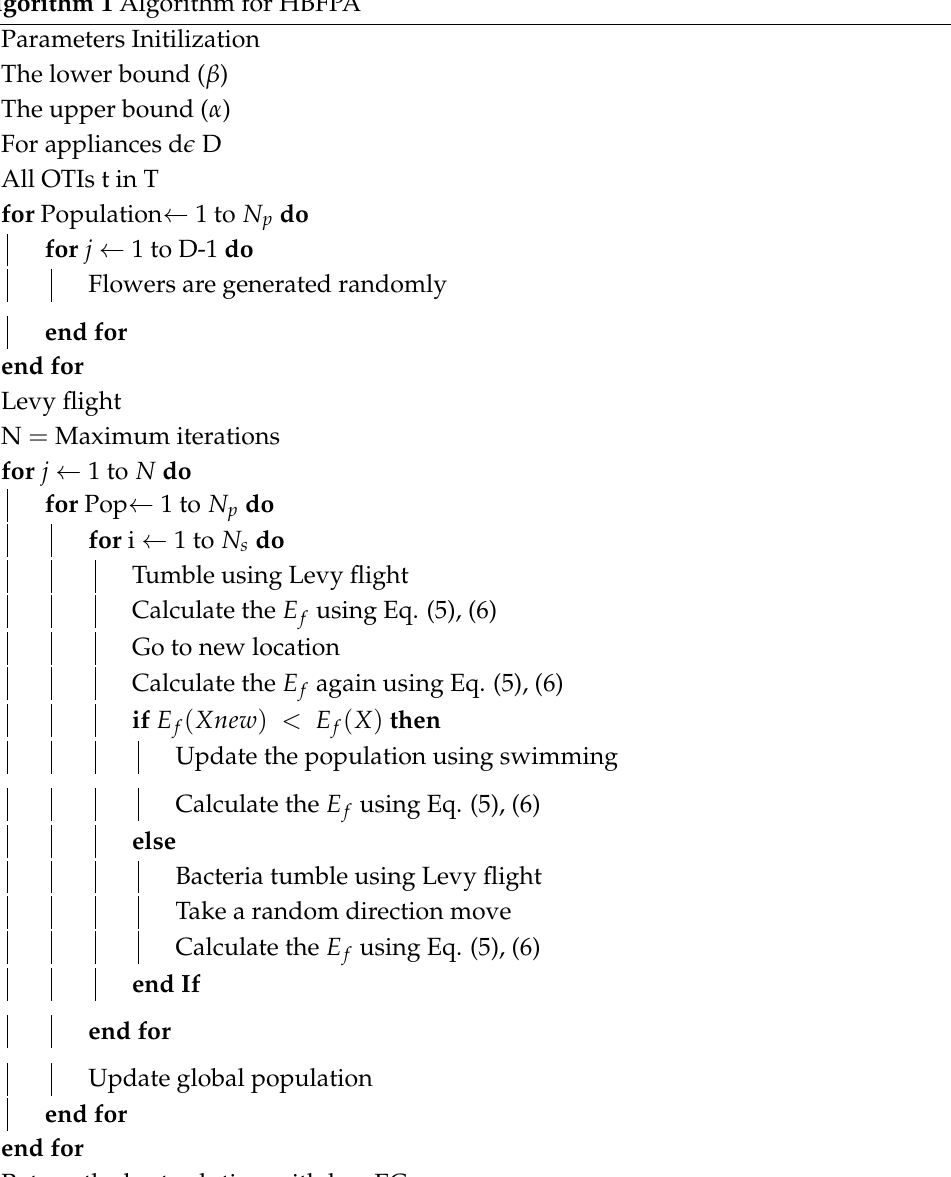
Algorithm 1 Algorithm for HBFPA